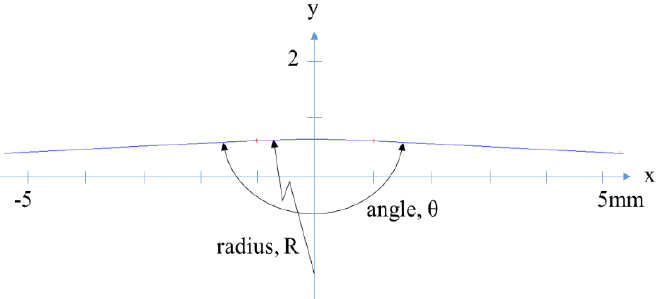
Figure 2. Sectional view of a subtle feature line.